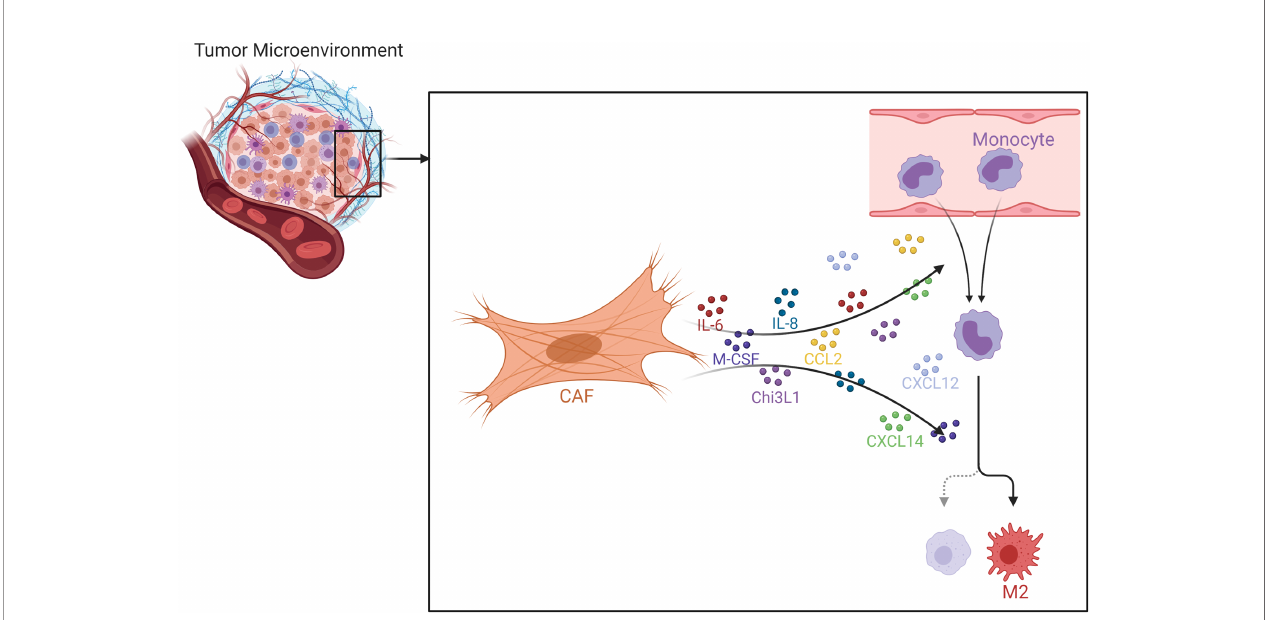
FIGURE 10 | Effects of CAFs on Macrophages. Various chemokines and cytokines secreted by CAFs may promote macrophage recruitment and M2 polarization. CAF, cancer associated fi broblast; Chi3L1, chitinase 3-like